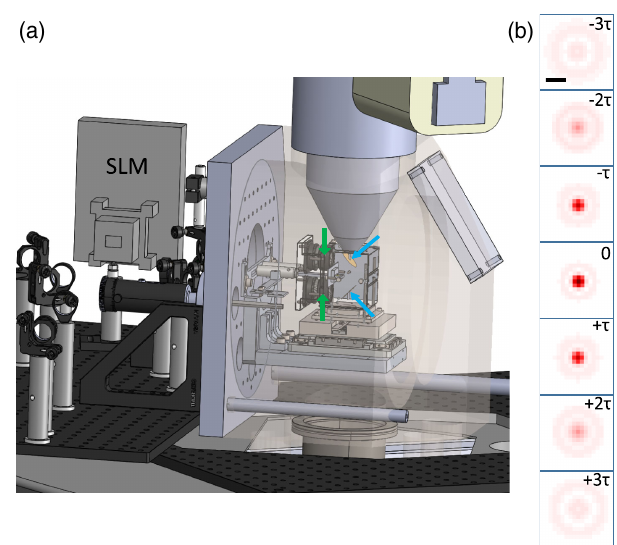
FIG. 7. (a) 3D drawing of the experimental setup, side view. (b) Series of simulated ponderomotive potentials (scale bar 45 μ m) in the conjugate plane after temporally displacing the laser pulse by multiples of τ . The same linear scale is used for all